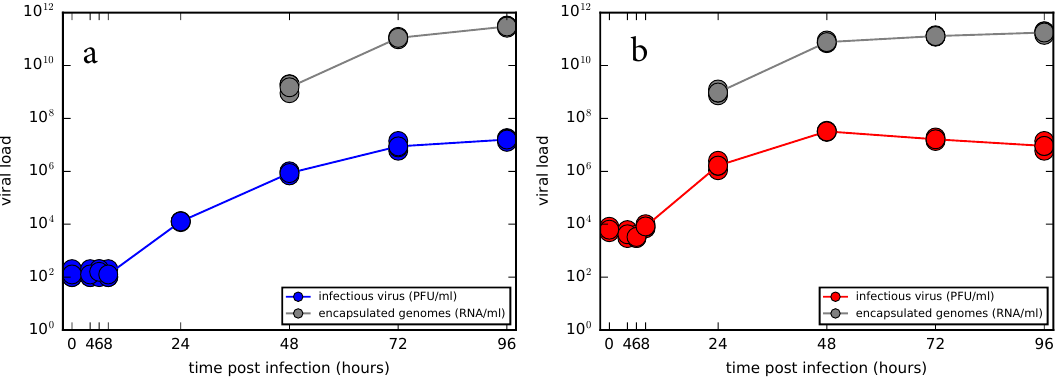
Figure 3. Time course kinetics of infectious virus and encapsulated genome concentrations for two distinct initial viral concentrations. ( a ) Multiplicity of infection (MOI) 0.01 and ( b ) 1 infectious units per cell.